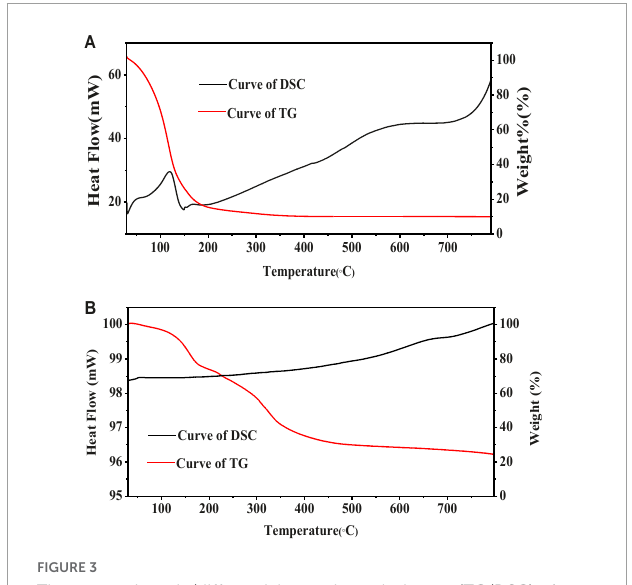
FIGURE3 Thermogravimetric/differential scanning calorimetry (TG/DSC) of Perilla essential oil (PEO) and Perilla essential oil microcapsules (PEOM) [PEO (A) and PEOM (B)